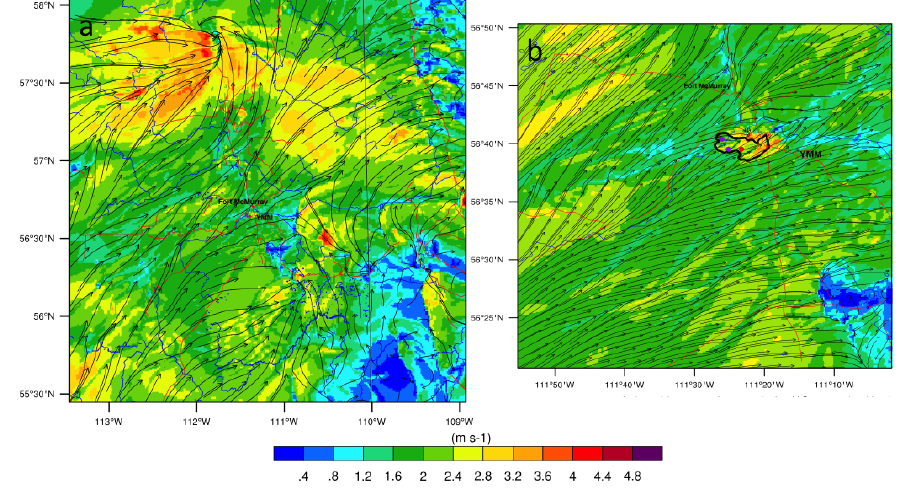
Figure 3. Wind speed and direction at 10 m above the ground from WRF outputs at 00 UTC on May 3, 2016. ( a ) The left image is 1 km resolution outputs and ( b ) uses a 200 m grid space resolution. The three purple (earlier) and red (later) dots are ignitions from hotspots within the model. The model burned area at 00 UTC on May 3, 2016 is presented by the thick black